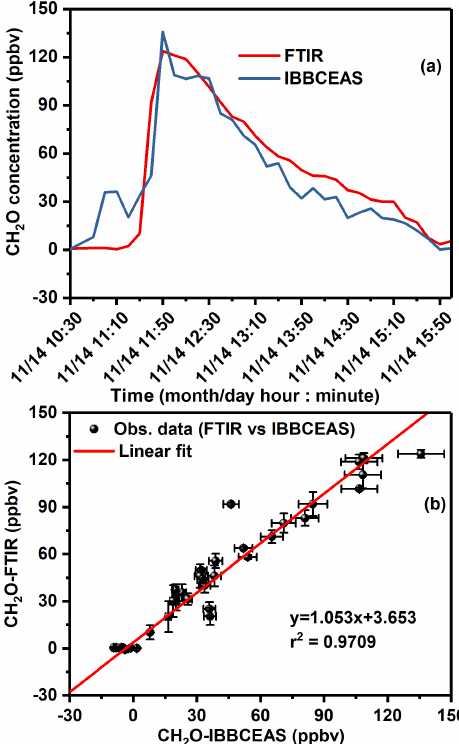
Figure 9. Intercomparison measurements of CH 2 O between IB- BCEAS and FTIR: (a) time series measurements of CH 2 O con- centrations from UV-LED-IBBCEAS and FTIR; (b) linear regres- sion of the measured CH 2 O in (a) IBBCEAS ( x axis) versus FTIR ( y